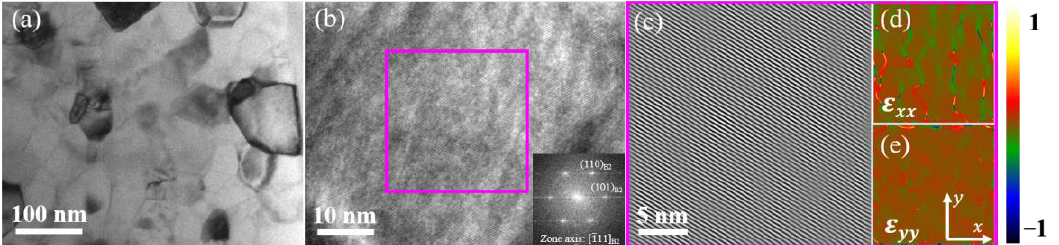
Figure 9. TEM observation of the as-received sample: ( a ) bright-field images; ( b ) high-resolution transmission electron microscope (HRTEM) images; ( c – e ) show the inverse fast Fourier transformation (IFFT) images and the geometric phase analysis (GPA) images of the pink square domain in ( b ).